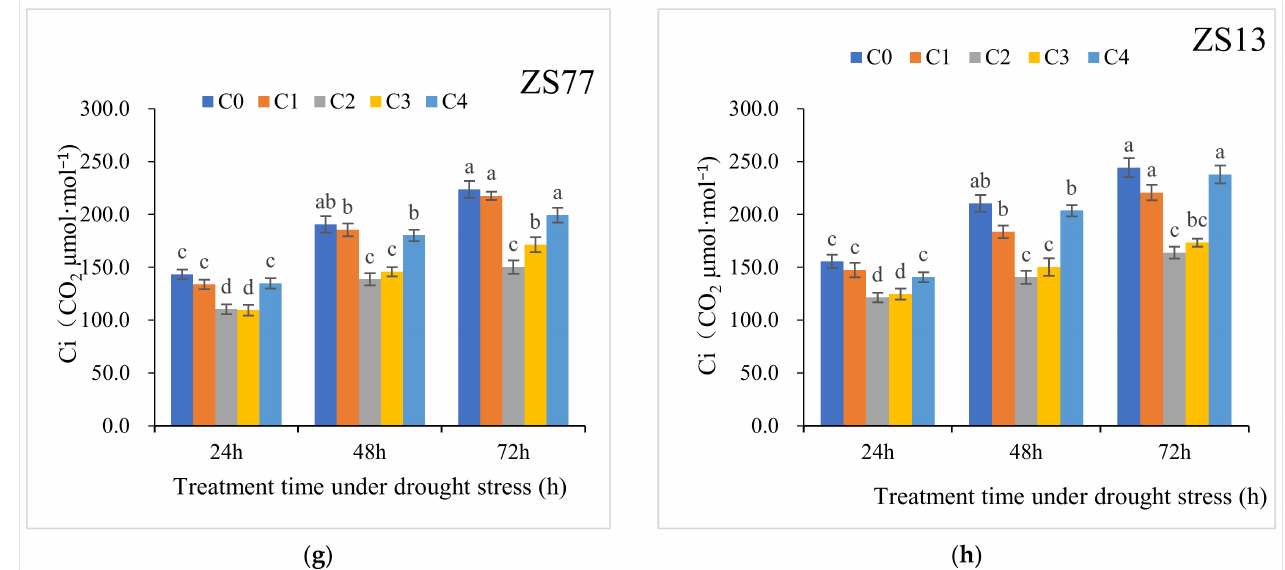
Figure 2. Effect of different concentrations of exogenous SA solution 0 (C0), 1.00 (C1), 2.00 (C2), 4.00 (C3), and 8.00 mg · L − 1 (C4) on Pn ( a , b ), Tr ( c , d ), Gs ( e , f ), and Ci ( g , h ) in sweet-potato leaves under drought stress. Bars with different letters indicate significant differences among treatments at 0.05 level (Duncan).